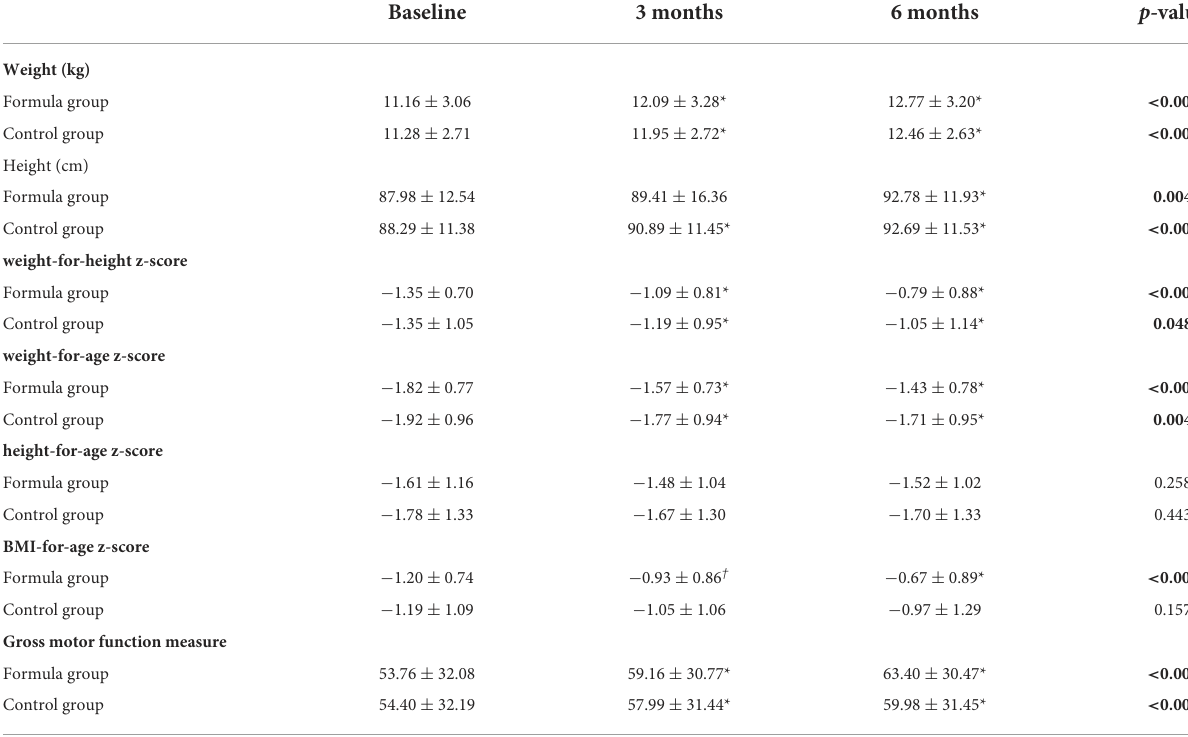
TABLE 2 Within-group comparison of nutritional parameters and GMFM